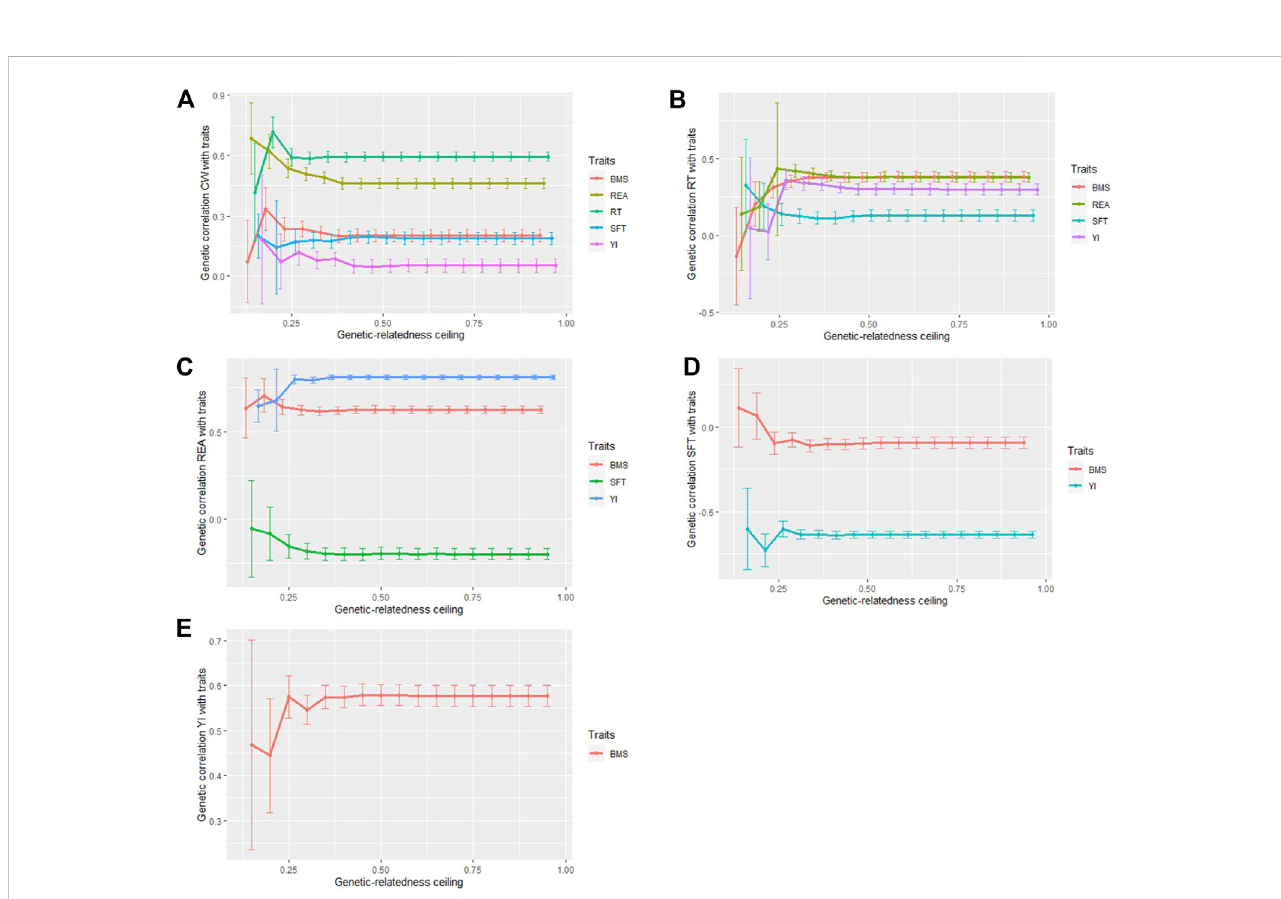
FIGURE 4 Genetic correlations between carcass traits in different genetic-relatedness ceilings. Genetic correlation between CW and REA, RT, SFT, YI, BMS (A) , RT and REA, SFT, YI, BMS (B) , REA and SFT, YI, BMS (C) , SFT and YI, BMS (D) , YI and BMS. (E) .